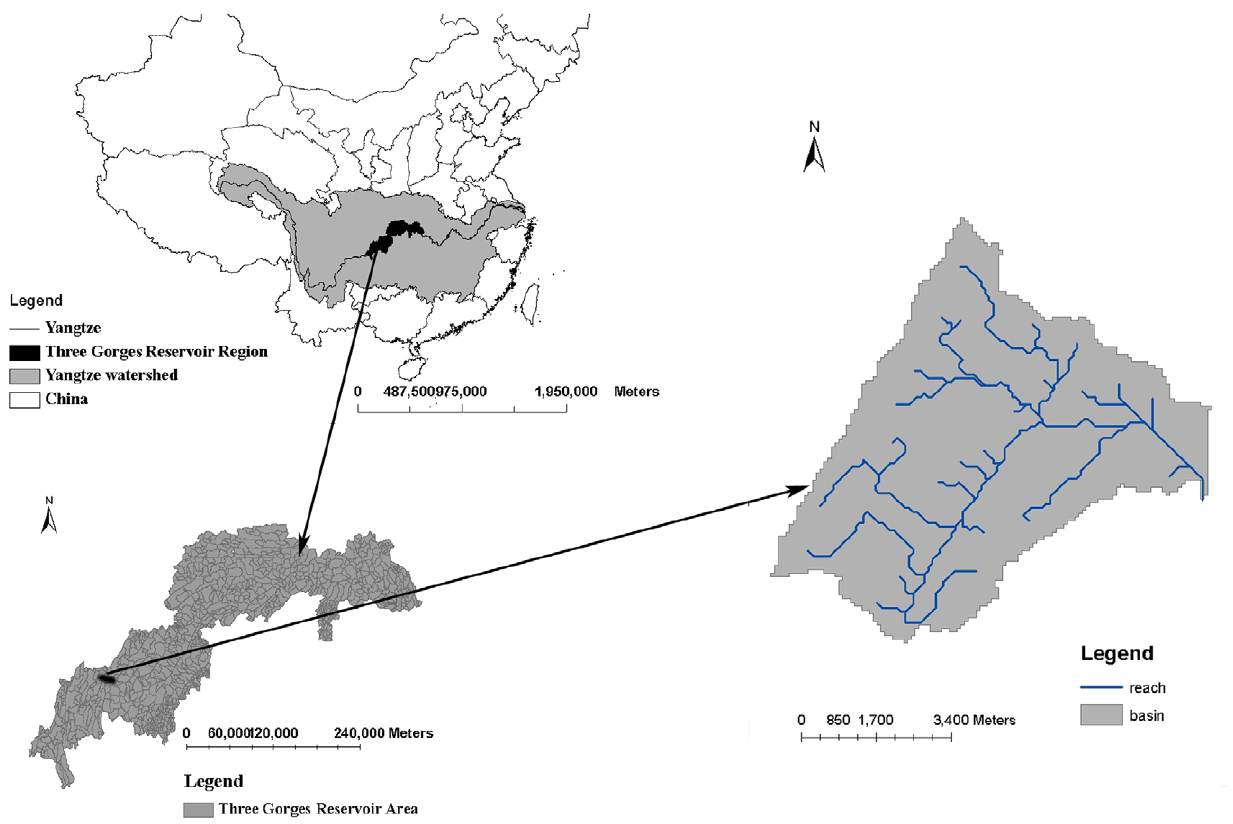
Figure 1. The location of the Yulin River watershed.